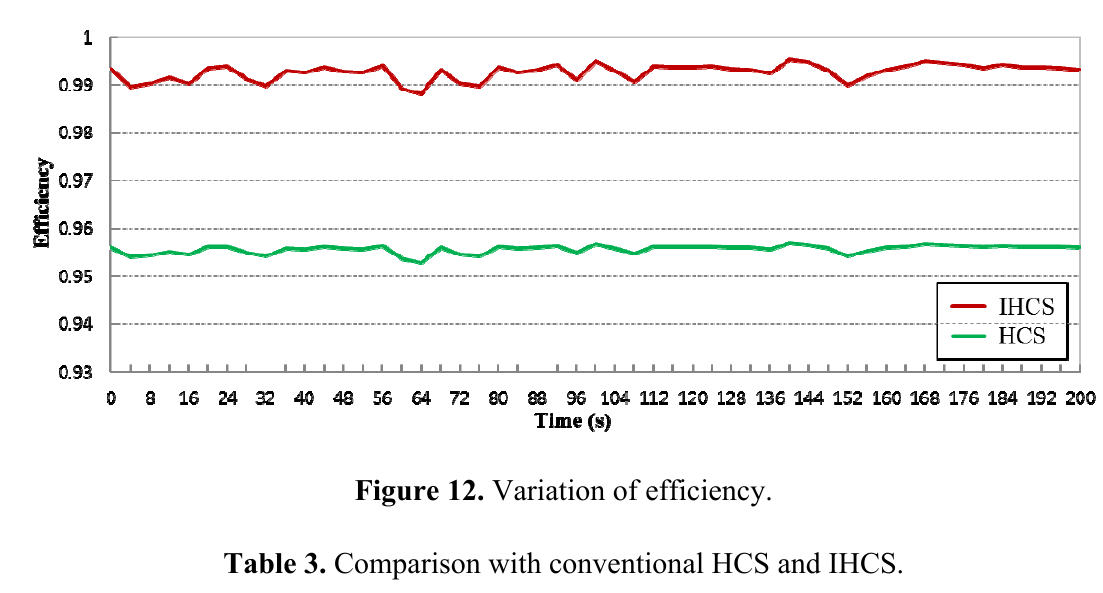
Figure 11. ( a ) Wind speed profile for PMSG wind turbine; ( b ) variation of rotational speed; ( c ) variation of active power; ( d ) variation of tip speed ratio (TSR); ( e ) variation of power coefficient.